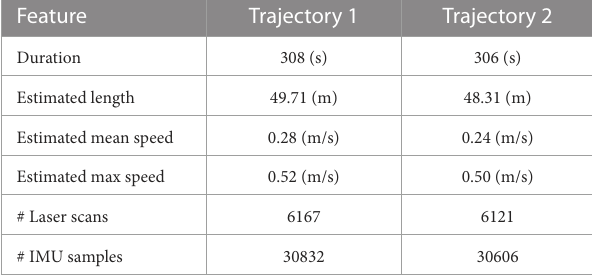
TABLE2 Informationaboutthetwotrajectoriesoftheindoorexperiment. Thefirstoneisusedtobuilda3DmapoftheenvironmentusingSLAM,while